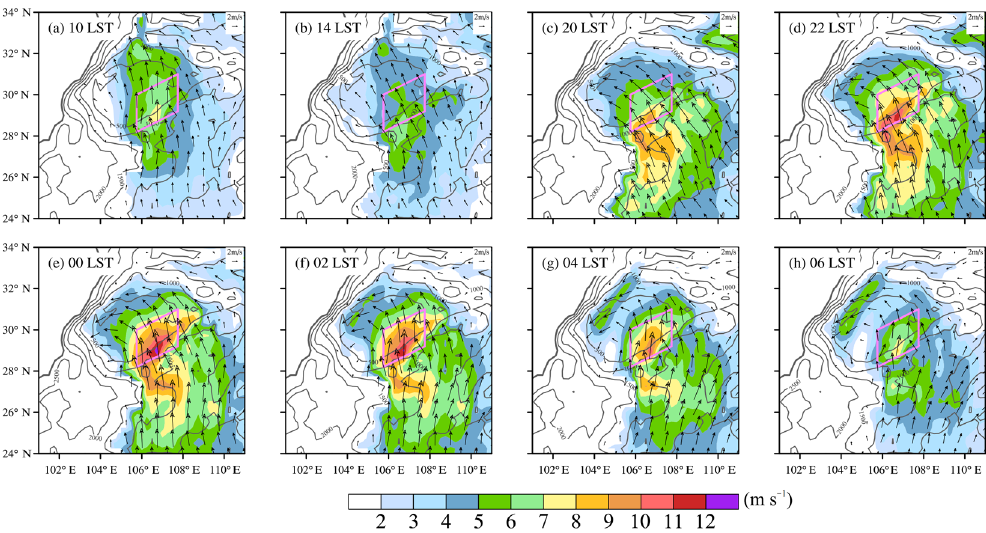
Figure 6. Diurnal variations of 850hPa wind field.